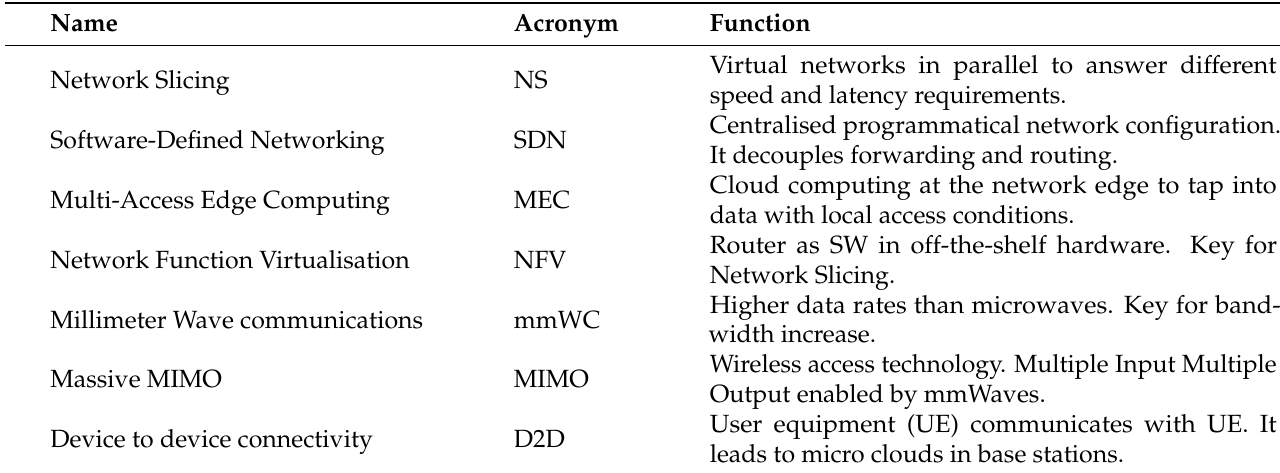
Table 2. Technologies used in 5G mobile